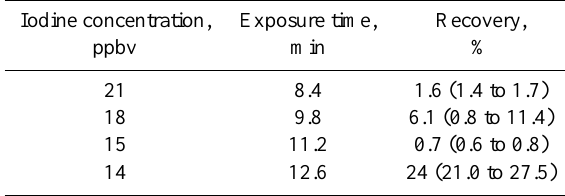
Table 1. Recoveries of iodine by denuder tubes at different iodine concentrations. Values are for the sum of two tubes in series, blank corrected and averaged for two repeat experiments (range given in